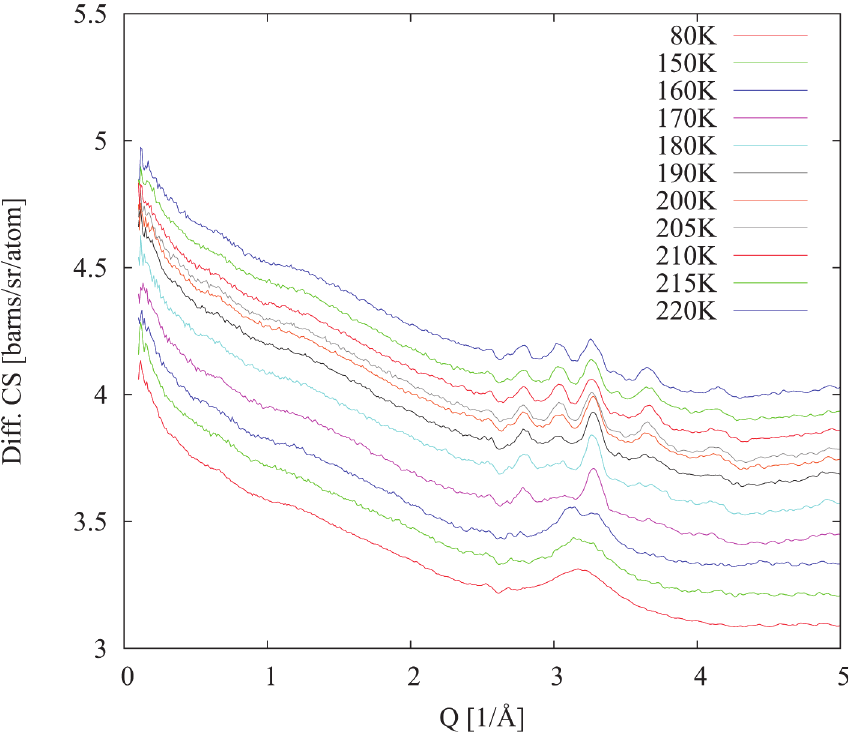
Fig 4. Differential cross sections for fully protiated sample. Heating after initial quench cooling. The crystallisation transition occurs between 160 K and 170 K.